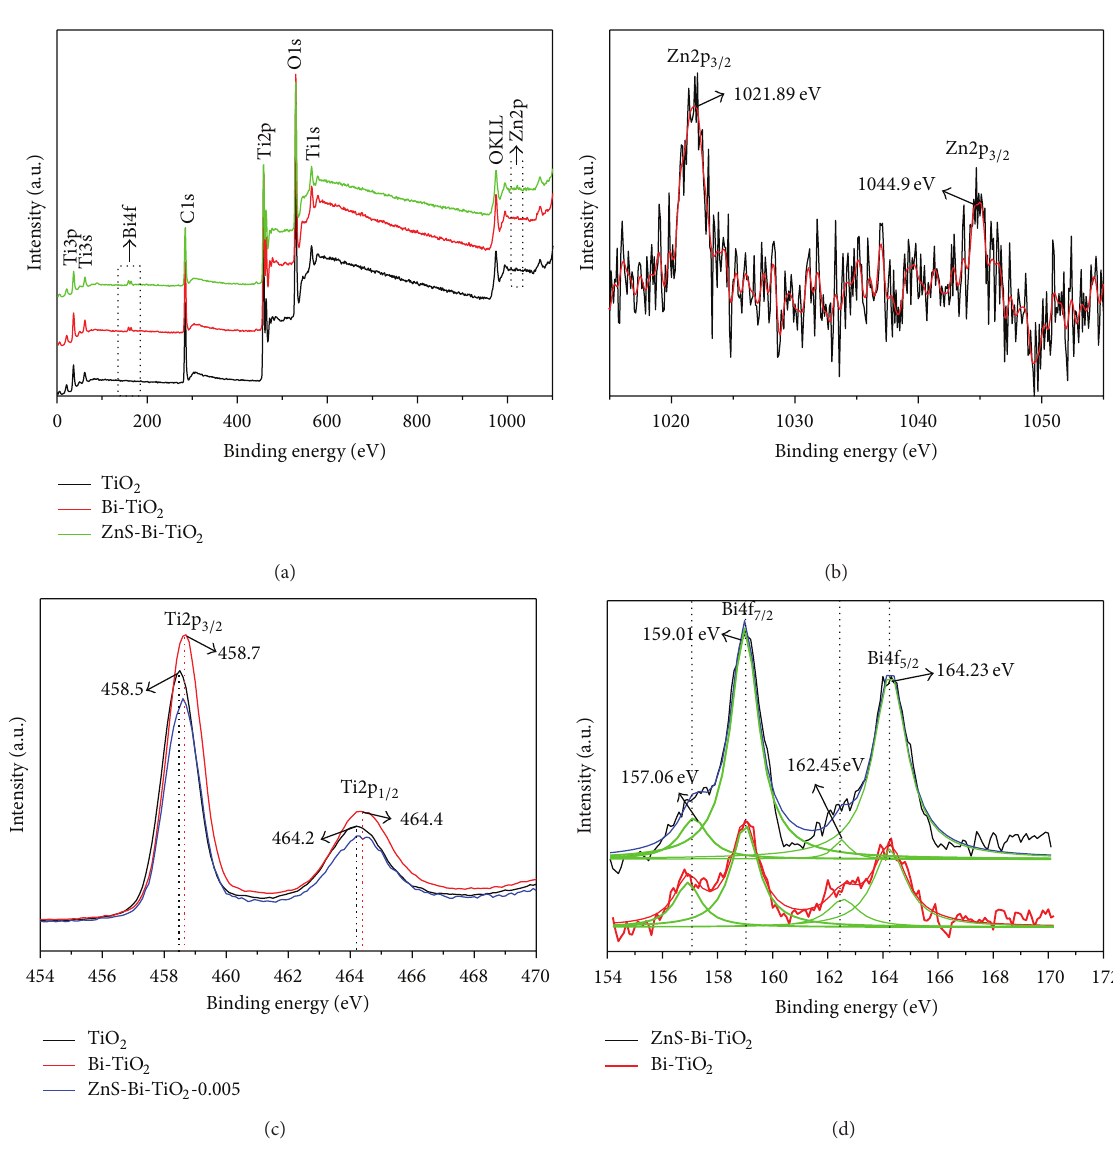
Figure 3: XPS spectra of (a) XPS survey spectra of samples, (b) XPS spectrum of Zn2p, (c) XPS spectrum of Ti2p, and (d) XPS spectrum of